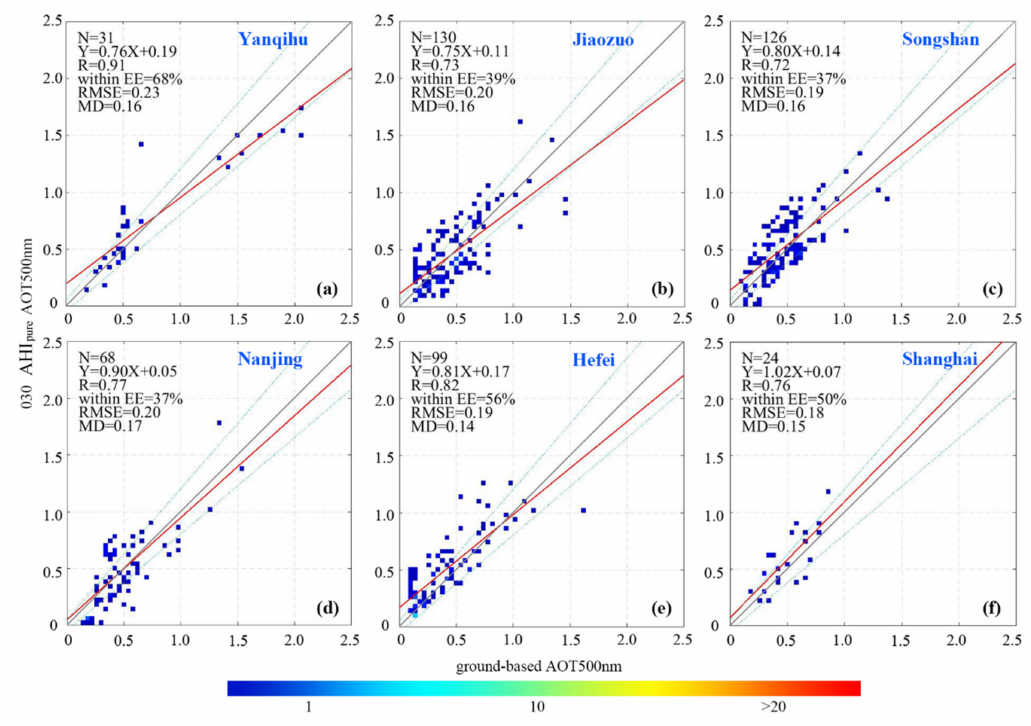
Figure 11. Scatterplots of the AOTs from H8 / AHI version 030 products against ground-based measurements from six Sun-Sky Radiometer Observation Network (SONET)